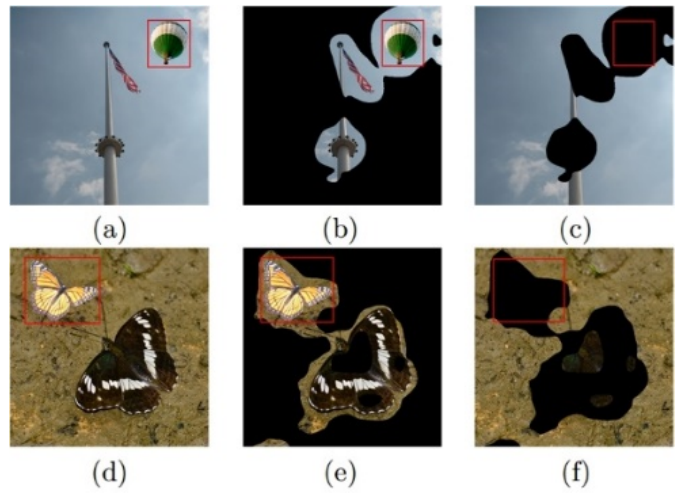
Figure 3. The separated ROI and RONI. ( a , d ) Tampered images; ( b , e ) ROI of images; ( c , f ) RONI of images.